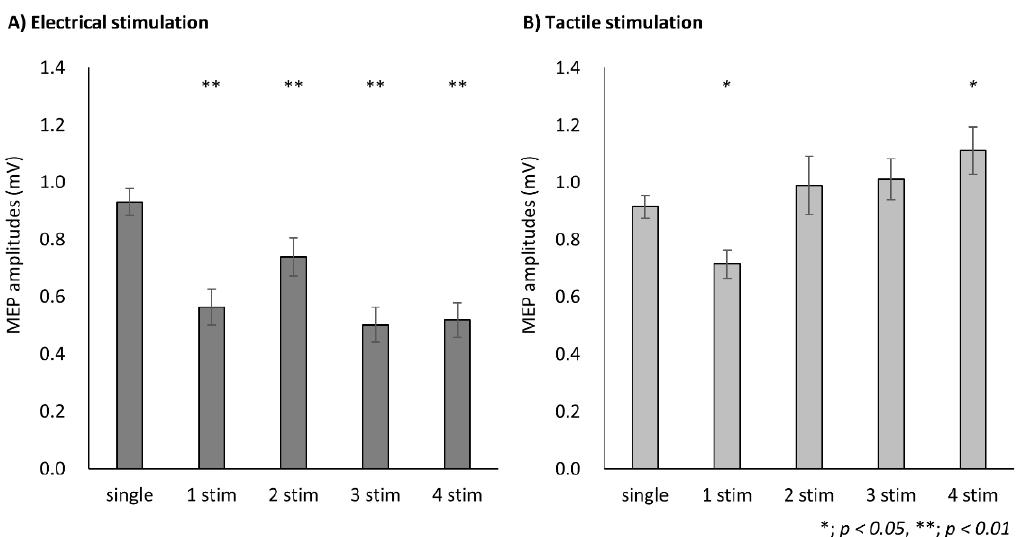
Figure 4. Modulation of motor evoked potentials (MEPs) according to the number of stimuli in each conditioning. Data are expressed as the mean ± standard error of the mean (SEM). ( A ) Modulation of MEP amplitudes with each number of electrical stimulations. The post hoc analysis showed a significant decrease in MEP in the presence of conditioning stimulation compared with that in the presence of single stimulation (1 stim, p < 0.001; 2 stim, p = 0.001; 3 stim, p < 0.001; 4 stim, p < 0.001). ( B ) The post hoc analysis showed a significant decrease in MEP at the conditioning stimulation of 1 stim compared with that at single stimulation ( p = 0.030) and a significant increase in MEP at 4 stim ( p =